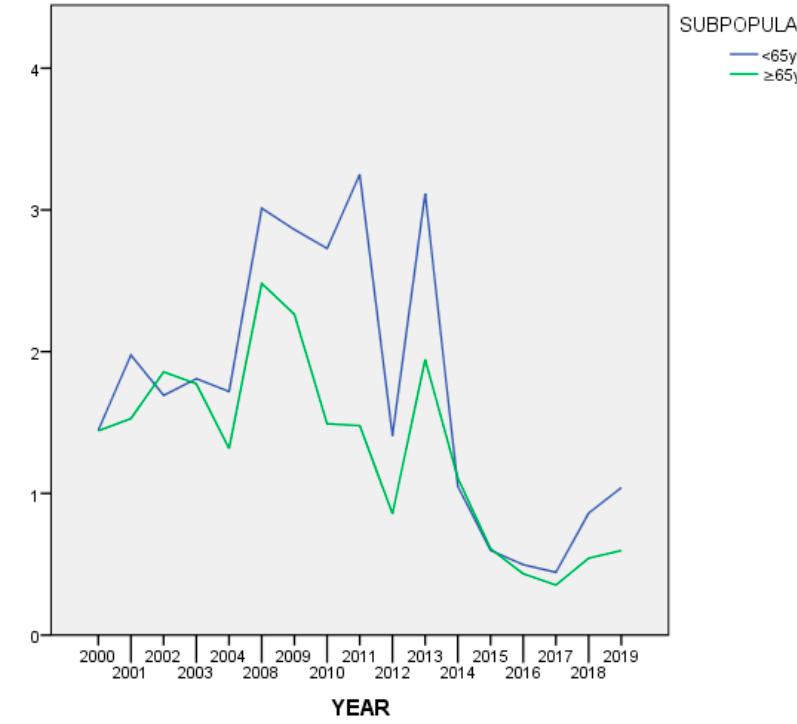
Figure 4. Mean waiting time from referral to assessment (days).